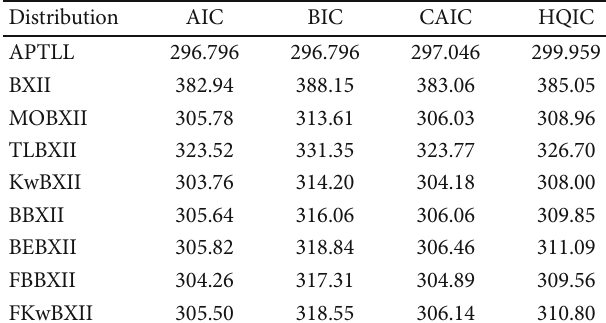
Table 6: Measures of goodness of fi ts for breaking stress